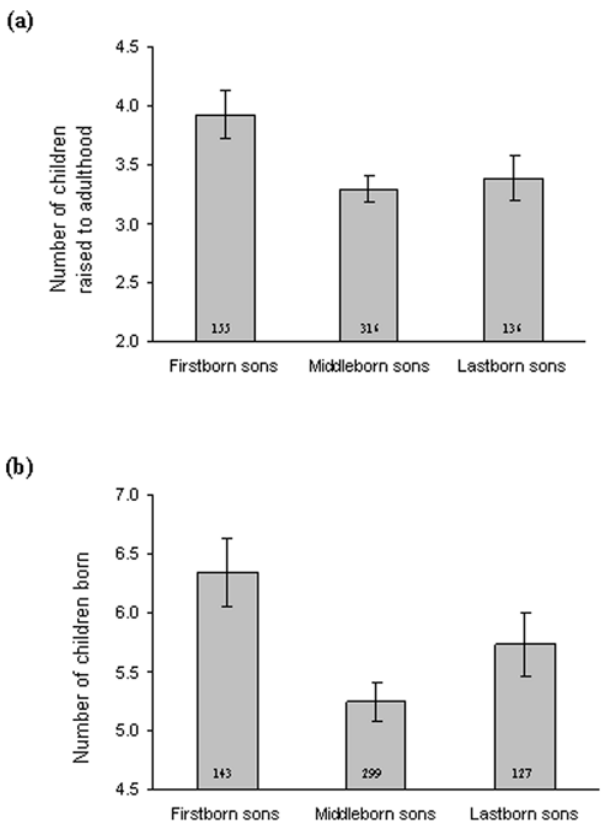
Figure 3. Reproductive success. (a) Lifetime reproductive success (LRS: number of children raised to age 15) as a function of intra-sex birth-order category (among sons): firstborn sons had the highest LRS, as compared to their younger brothers ( x 2 2 =5.26, p =0.07). No such effect was found among sisters ( x 2 2 =1.60, p =0.45, not shown in the figure). (b) Lifetime fecundity (number of children produced) as a function of intra-sex birth-order category (among sons): firstborn sons had the highest fecundity, as compared to their younger brothers ( x 2 2 =12.91, p =0.002). No such effect was found among sisters ( x 2 2 =1.33, p =0.5, not shown in the figure). Figures show predicted values of the minimal model, error bars represent standard errors of the means and sample sizes are indicated at the bottom of the bars.